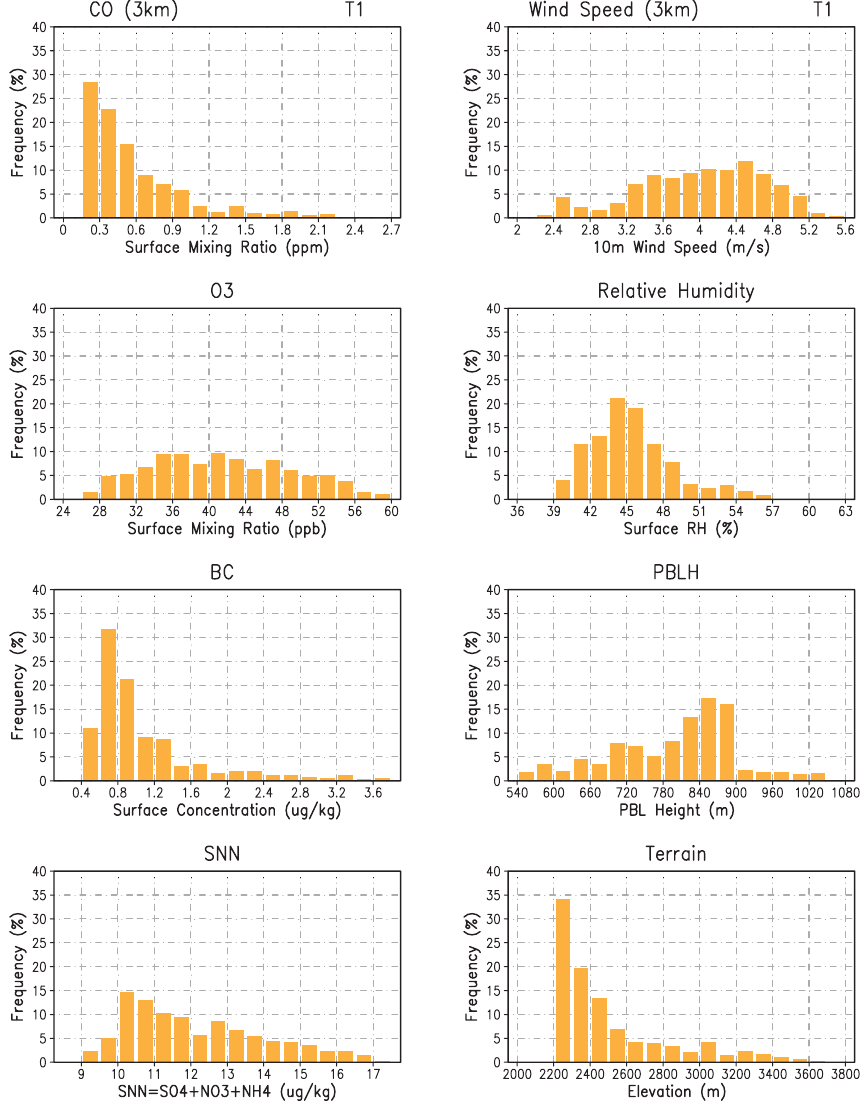
Fig. 9. Probability density functions (PDF) of values from the 3-km simulation that lie within the 75-km host grid cell for the T1 site for the following variables: CO, O 3 , BC, SNN (SO 4 +NO 3 +NH 4 ) , wind speed, relative humidity, PBL height, and terrain height. The PDFs encompass the time period 5–30 March